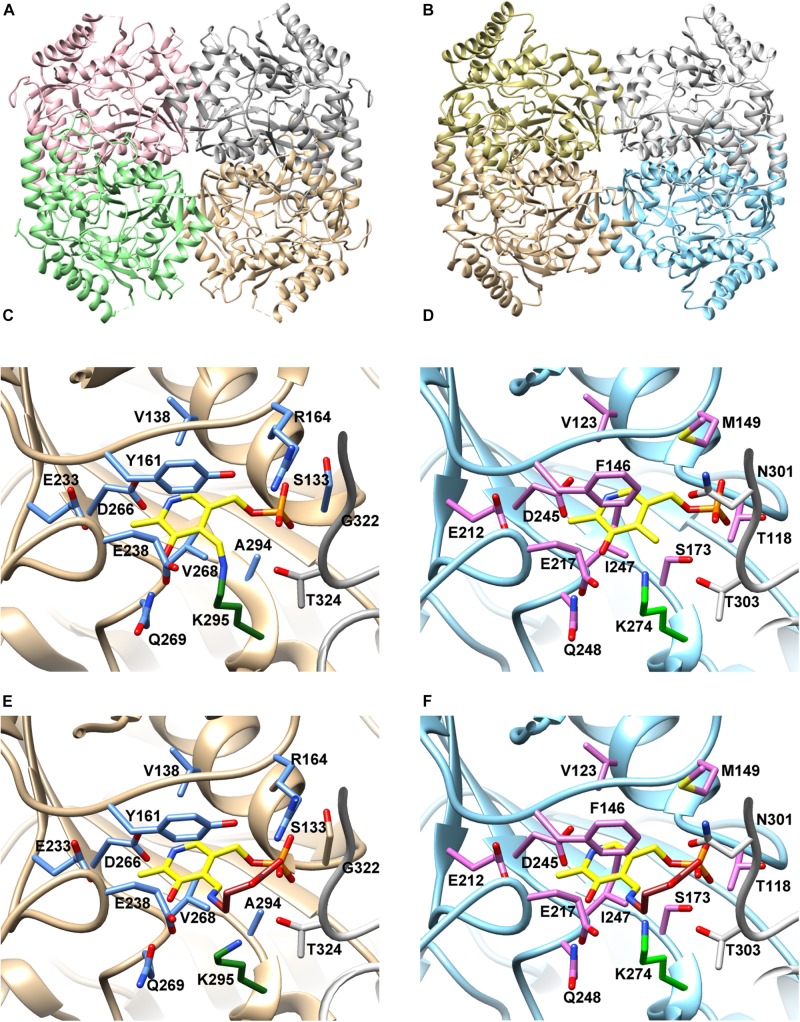
Structural model of (Pl)EctB. (A) Crystal structure of the GABA-TA from A. aurescens (PDB-ID: 4ATP) and (B) the SWISS-MODEL of (Pl)EctB. Different color schemes highlight monomeric subunits within the tetrameric assembly of A. aurescens GABA-Ta (A) and in the model of the (Pl)EctB aminotransferase (B). (C) The architecture of the PLP-binding site, formed by two monomeric subunits, of (Aa)GABA-TA (PDB-ID: 4ATP) shows the PLP-binding amino acid residues including the covalent binding of PLP (yellow) to Lys295 (green) forming the internal aldemine (Bruce et al., 2012). The side-chains of amino acid residues implicated in the binding of PLP (C) and of the internal aldemine (the PLP-GABA adduct) are shown in blue and gray in stick format. (D) Overlay of (Aa)GABA-TA in its internal aldemine form with the (Pl)EctB model illustrates the similarity of the active sites from both enzymes, identifying Lys274 in (Pl)EctB as the residue to which PLP (yellow) is bound. The side-chains of amino acid residues implicated in the binding of PLP (C) and of the internal aldemine are shown in magenta and gray in stick format. (E) Crystal structure of (Aa)GABA-TA in the PLP-GABA-adduct bound form (PDB-ID: 4ATQ) (the external aldemine). Note: the carboxyl-group of GABA is coordinated via interactions with the side chain of Arg164. (F) An overlay of (Aa)GABA-TA in its external aldemine form with the (Pl)EctB model. Arg164 of (Aa)GABA-TA is replaced in (Pl)EctB by a conserved Met149 residue from the same subunit. A loop from the adjacent sub-unit (depicted in gray) contributes to the formation of the binding site in (Aa)GABA-TA and involves residues Gly322 and Thr324 (Bruce et al., 2012). In the (Pl)EctB model, residues Asn301 and Thr303 might serve this function.